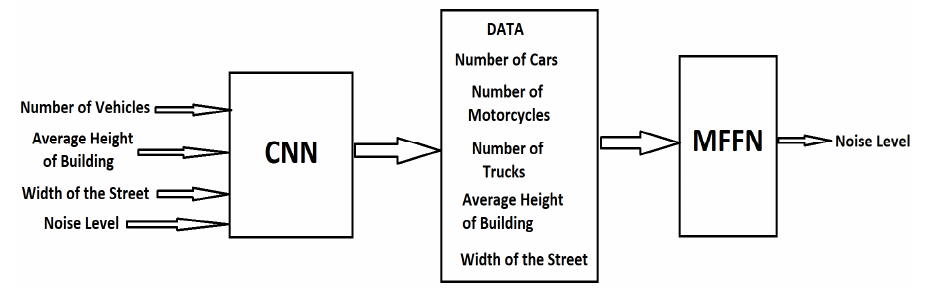
Figure 22. The neural architecture